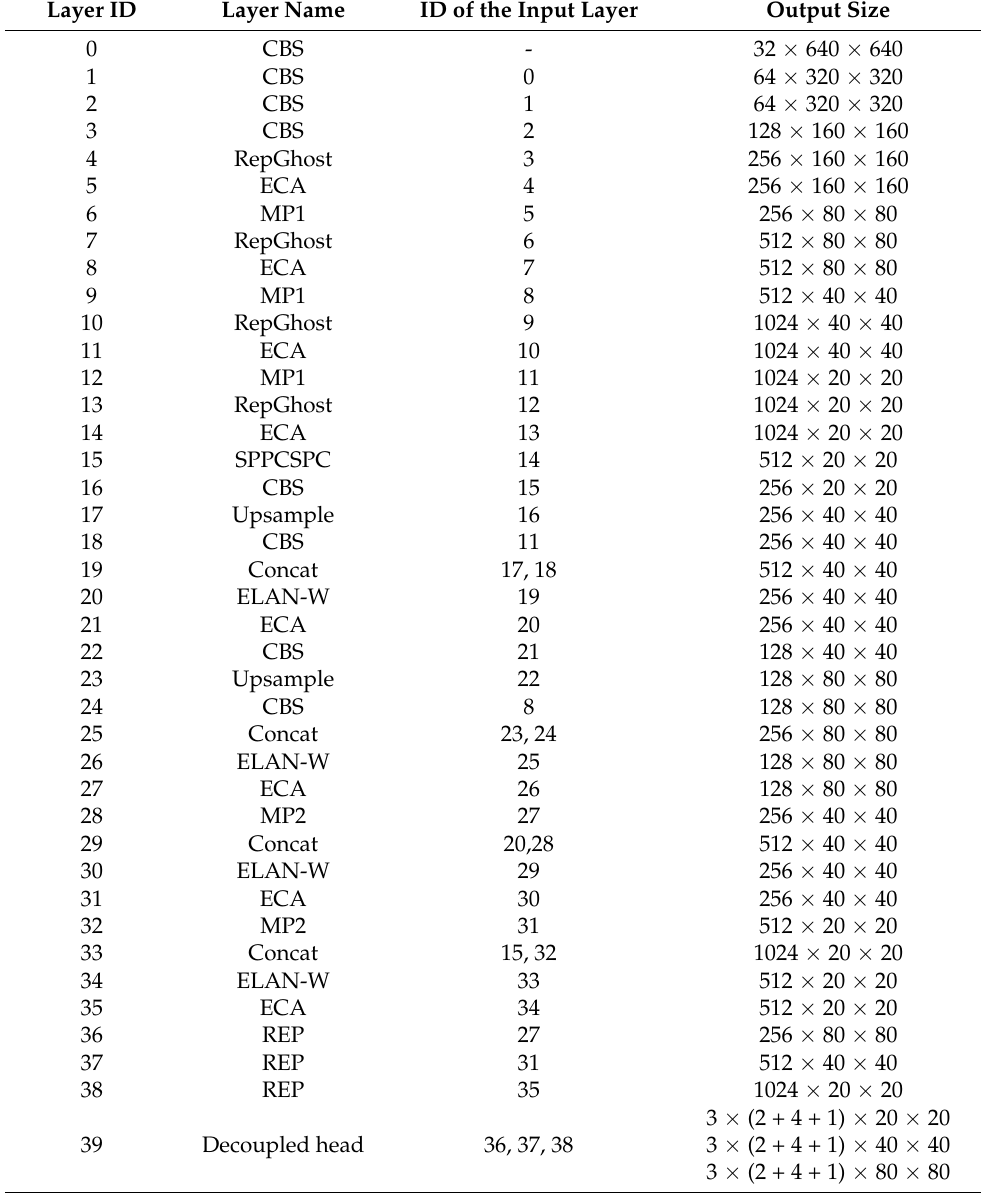
Table 3. The structure parameter of the RDE-YOLOv7